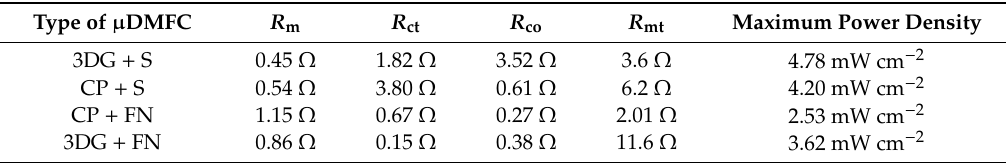
Figure 7. Equivalent circuit (Randles circuit). Table 3. Fitted parameters of the Nyquist plots. Table 3. Fitted parameters of the Nyquist plots.